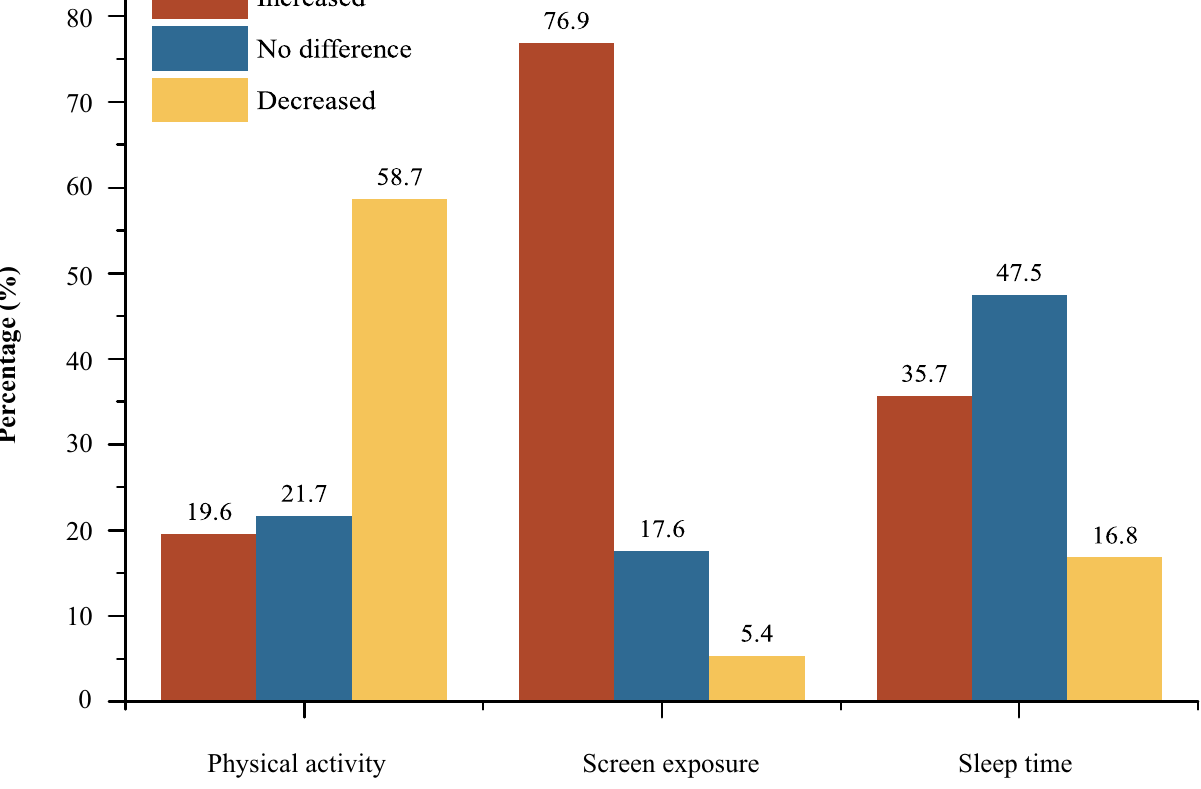
Figure 2. Changes in durations of physical activity, screen exposure and sleep time in students after the outbreak of